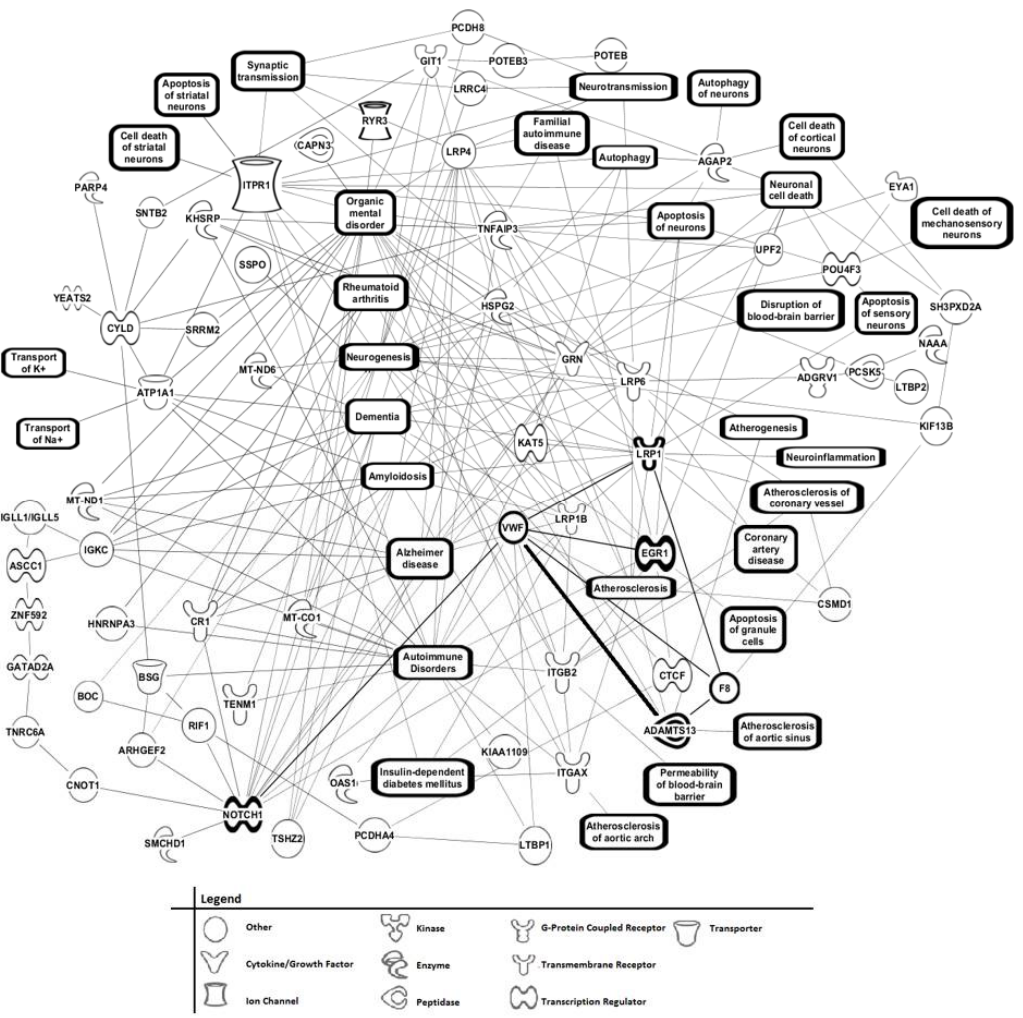
Figure 7. IPA of m / z “range” MS/MS serum data from mild AD patients vs. control subject comparison using top 119 peptides/proteins from Tables 3 and 4. IPA m / z range MS/MS serum data analysis for mild AD patients vs. controls using top 119 peptide/proteins from Tables 3 and 4. Ingenuity Pathway Analysis (IPA), Qiagen, Inc.) of the 119 peptides/proteins exhibited in Tables 3 and 4 having a 2x difference in positive sera number between mild AD patients and controls, and a 1.5x difference in MS/MS “hit” [single-peptide identification] ratio between the two groups. The protein function symbol legend is at the bottom of the figure.